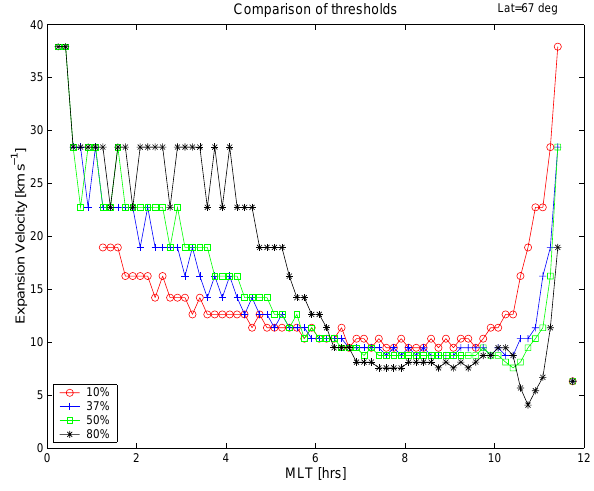
Fig. 6. A comparison of the velocities of the expansion of the re- sponse to reconnection as determined using relative threshold anal- ysis (method 4). The threshold temperatures are calculated as a percentage of the peak temperature change measured for each sim- ulated